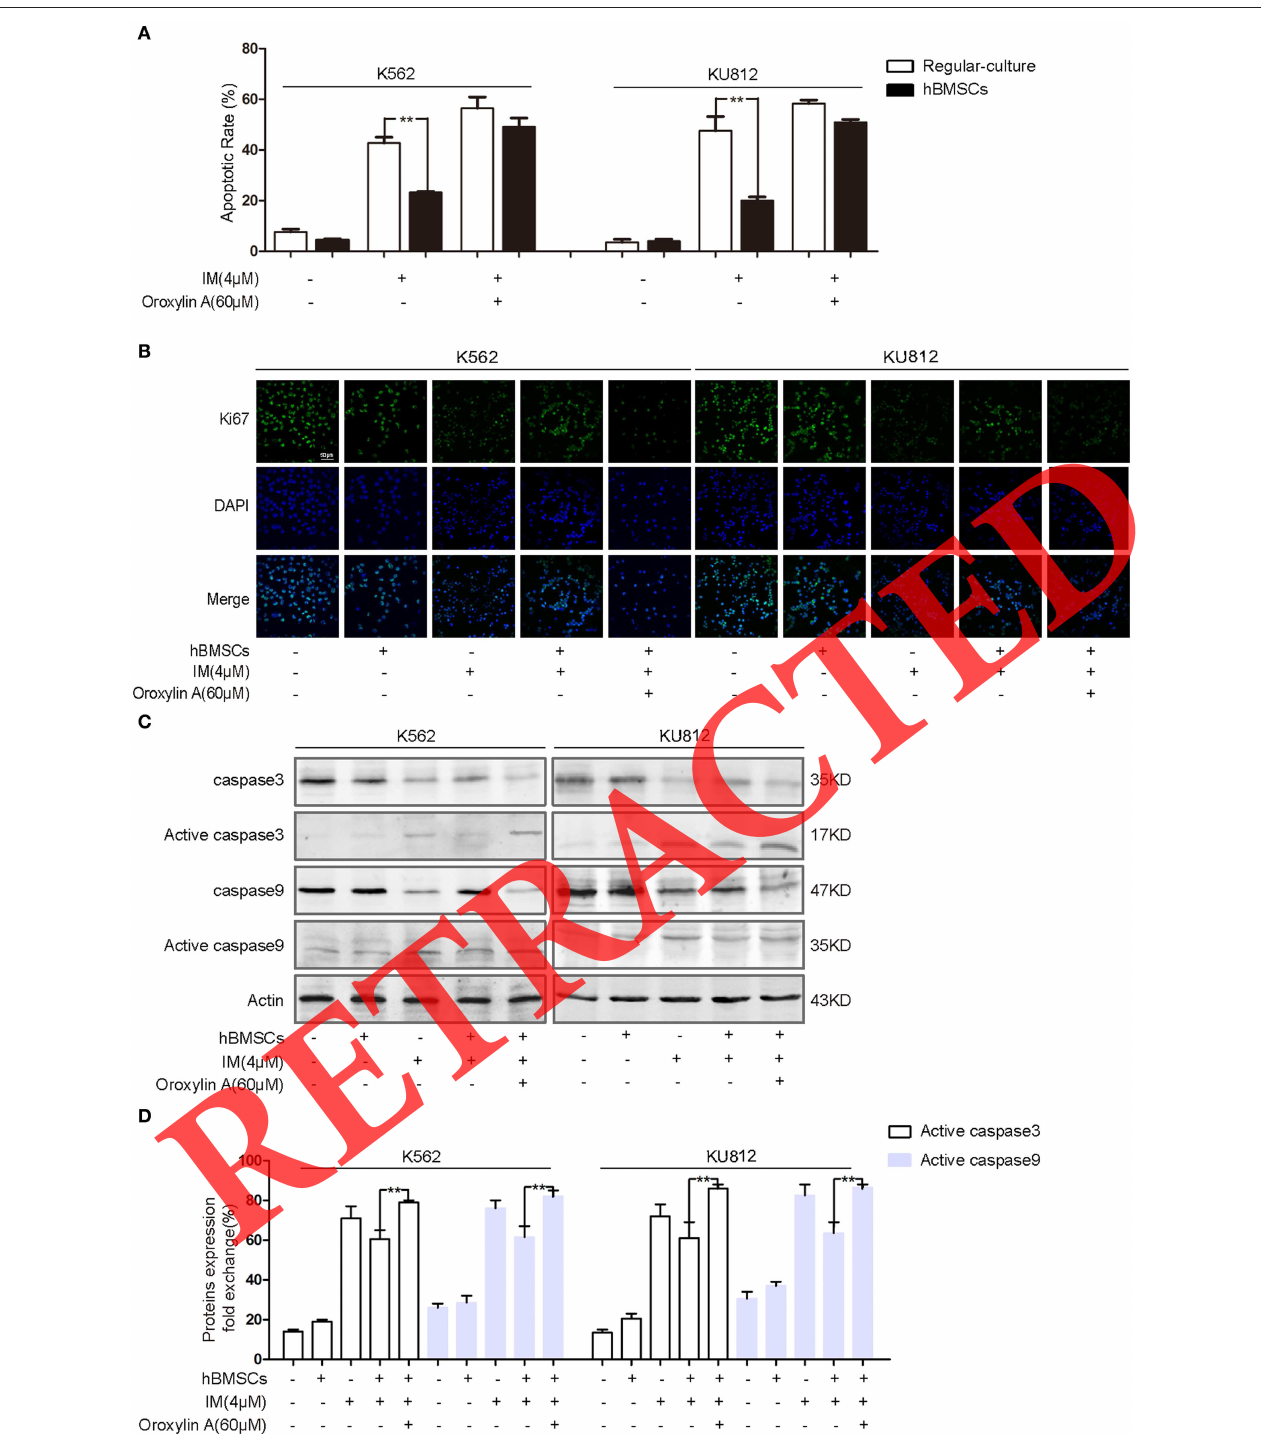
FIGURE 4 | Oroxylin A reversed the effect of protection of BMSCs on CML cells. K562 and KU812 cells were cultured with or without IM and Oroxylin A in normal group or co-culture group for 48h. Cell proliferation was determined by Annexin V-PI double-staining assay and Ki67 cell proliferation detection. (A) Percentage of apoptosis in K562 and KU812 cells after treatment. (B) Ki67 cell proliferation detection. (C) The expression of cleaved-caspase3 and 9 was determined using western blot analysis. (D) Analysis of proteins expression. Data (A) and (D) were shown as Means Å SD for three independent experiments. (* p < 0.05 and ** p < 0.01).